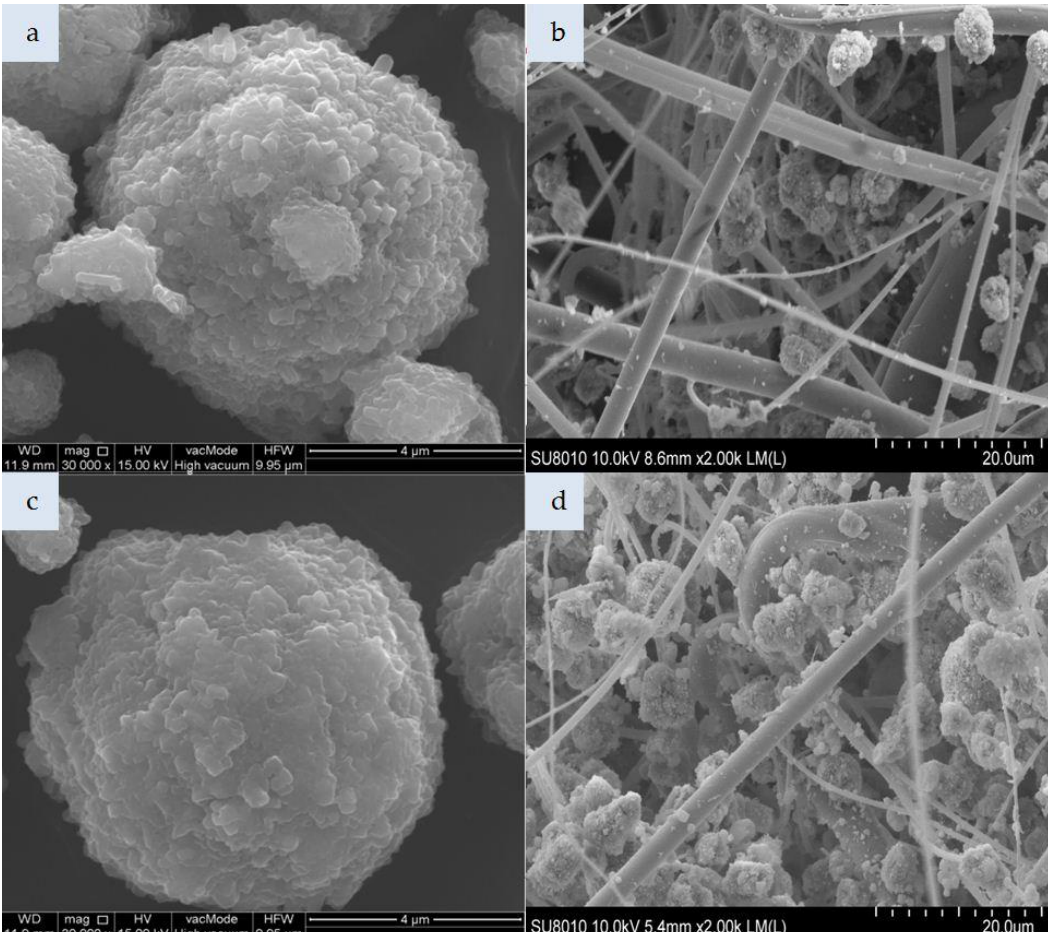
Figure 3. Photomicrograph: ( a ) unmodified zeolite Na-P1, ( b ) nonwoven composite with zeolite Na-P1, ( c ) zeolite Na-P1 modified with HDTMA, ( d ) nonwoven composite with zeolite Na-P1 HDTMA (magnification: a,c – x30.00k; b,d – x2.00k).